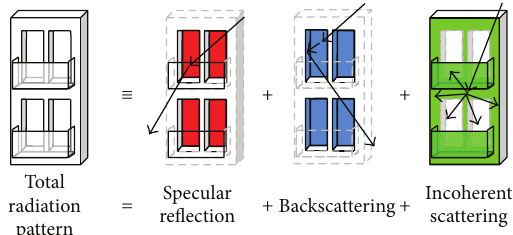
Figure 5: Decomposition principle of the 3CM